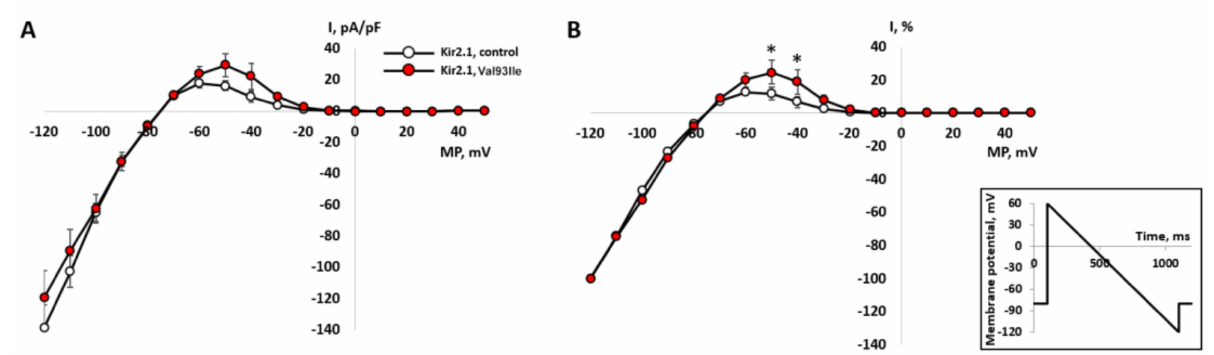
Figure 4. Background inward rectifier potassium current IK1 recorded in CHO-K1 cells transfected with the wild-type gene of Kir2.1 channel (n = 10) and the mutant gene (n = 9). The current was elicited by hyperpolarizing ramp protocol (see inset) from the holding potential of -80 mV. ( A )—I-V curves of IK1 in absolute values of current density. ( B )—comparison of normalized I-V curves in % of inward current maximum measured at − 120 mV. The current values for each cell were normalized independently and averaged after normalization. *—significant difference mutant vs.